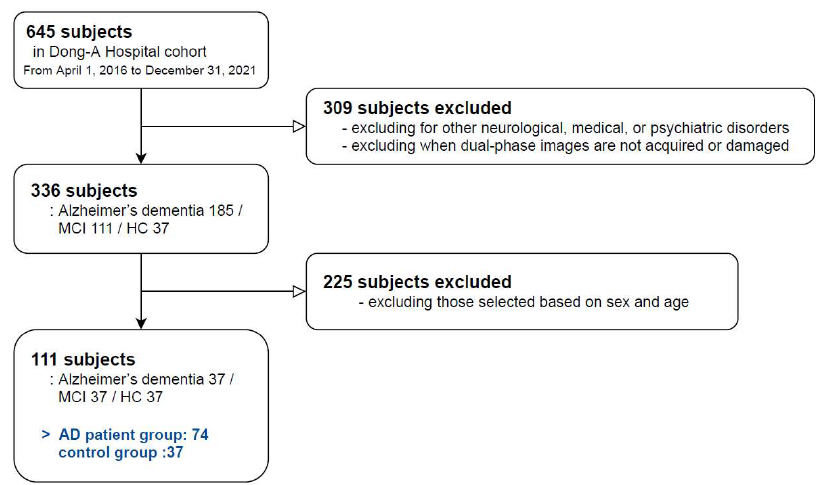
Figure 1. Selection of subjects. MCI: mild cognitive impairment, HC: healthy control, AD: Alzheimer’s disease.